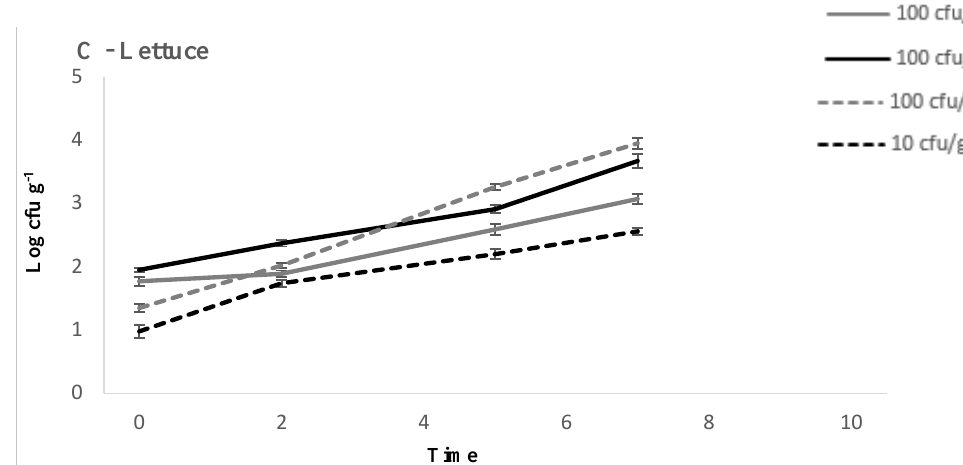
Figure 1. Growth and survival of L. monocytogenes in ( A ) spinach, ( B ) rocket, and ( C ) lettuce at 10–100 cfu g − 1 inoculation densities at 8 ◦ C. ( ± ) error bars indicate standard deviation. Solid black, solid grey, and dashed grey lines represent experiments with 100 cfu g − 1 starting inoculum density, and dashed black line represents experiment with 10 cfu g − 1 starting inoculum density. Table 2. Growth potentials (based on median values of results from day 0 and day 9) of L. monocytogenes in ready-to-eat leafy vegetables.